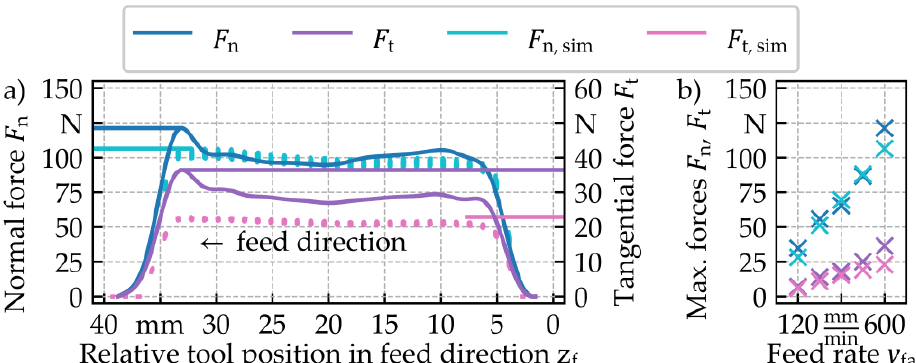
Figure 14. ( a ) Comparison of metrologically recorded and simulated ITG process forces in the laboratory setting at v fa = 600 mm/min. ( b ) Maxima of tangential and normal forces depending on feed rate. Process conditions are given in Table 1.